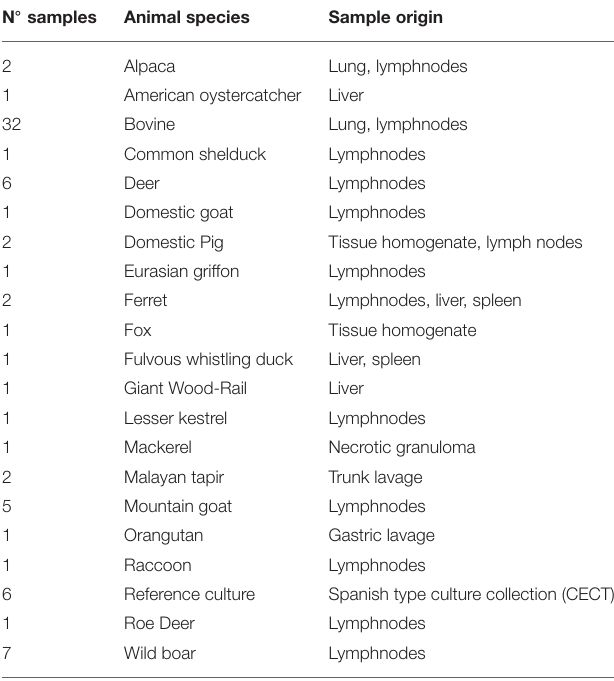
TABLE 1 | Samples ( n = 75) analysed in this